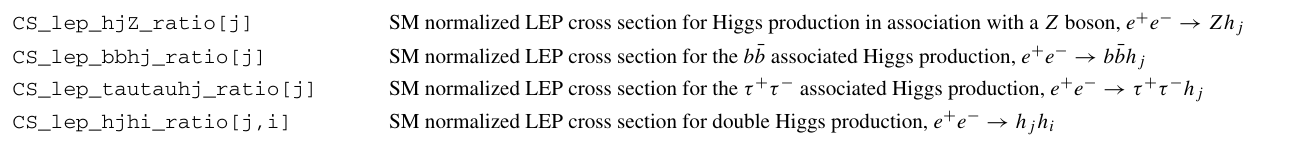
Table 2 LEP cross section input for neutral Higgs bosons. These are unchanged with respect to HiggsBounds-4 CS_lep_hjZ_ratio[j]